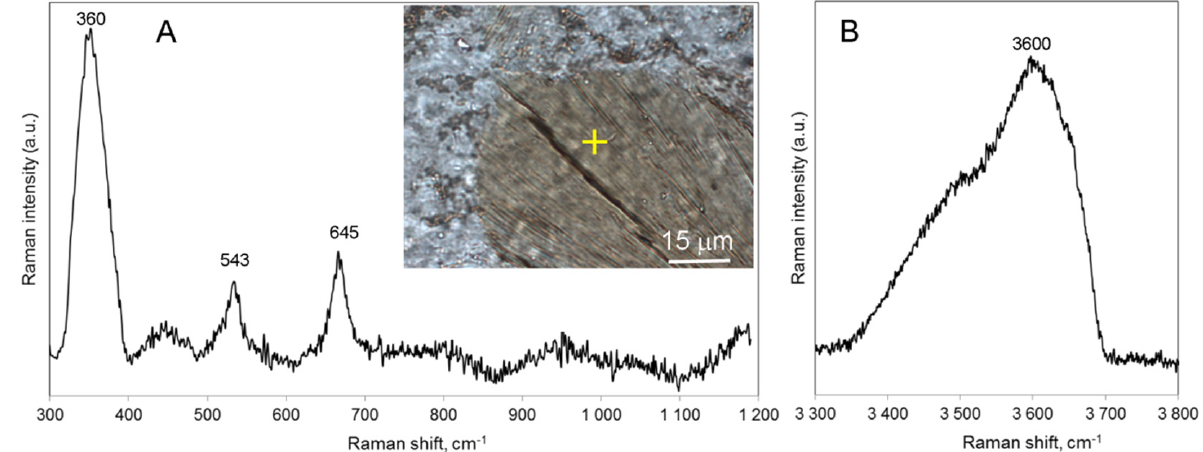
Figure 9. Micrographs and Raman spectra of plate-like chlorite in the amygdale of vesicular basalts in the spectral range of 300 − 1200 cm − 1 ( A ) and 3300 − 3800 cm − 1 ( B ). The analytical spot is marked by a yellow cross.